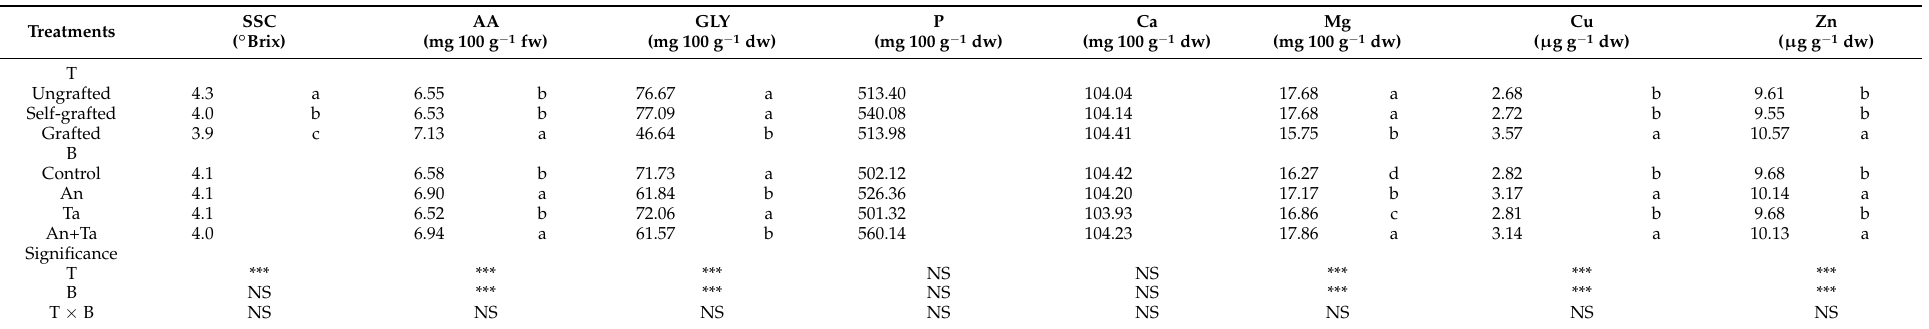
Table 2. Effect of plant type (T) and biostimulant (B) on soluble solids content (SSC), ascorbic acid (AA), glycoalkaloids (GLY), phosphorous (P), calcium